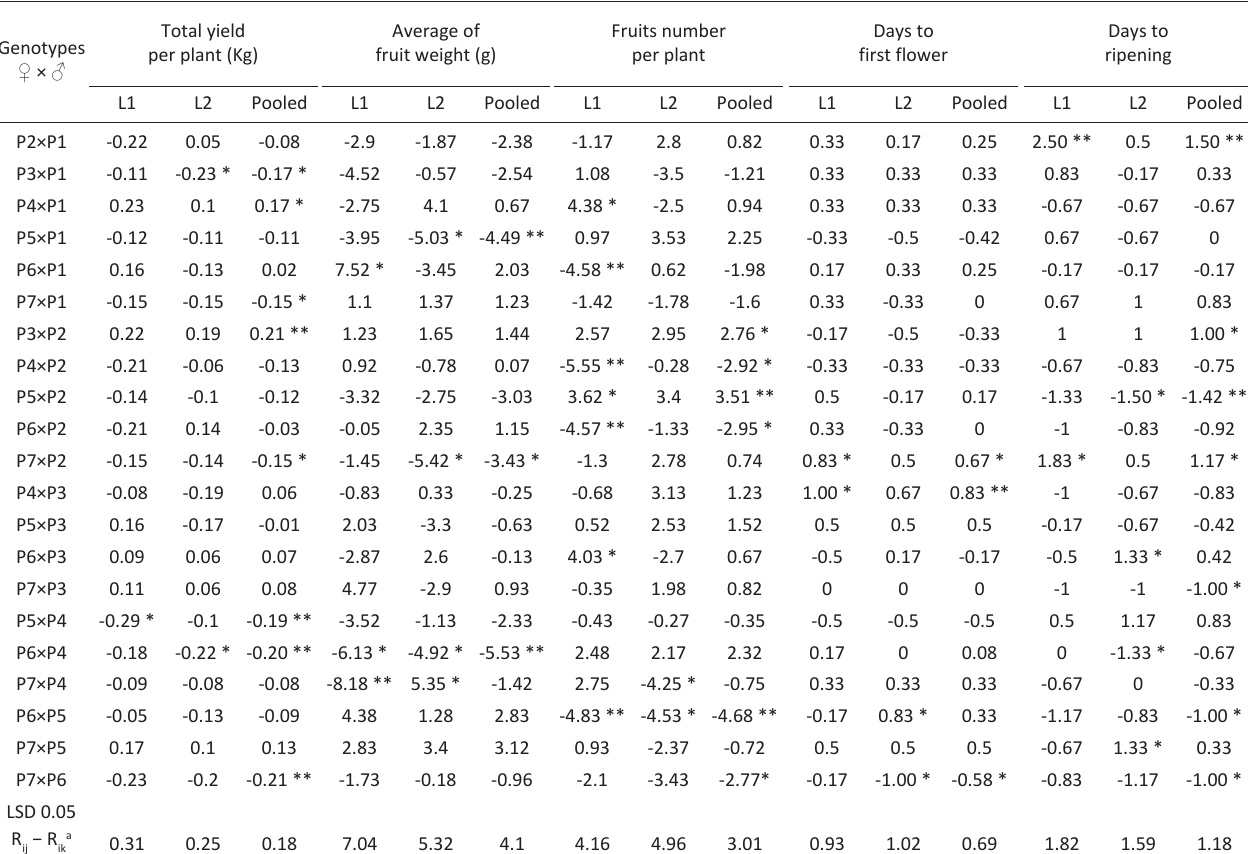
P1= Perimoga, P2= La1793, P3= AC06, P4= CT6, P5= MC3, P6= C20, P7= Kingstone. * Significant at P<0.05 level, ** Significant at P<0.01 level. a Difference between two RCA of two